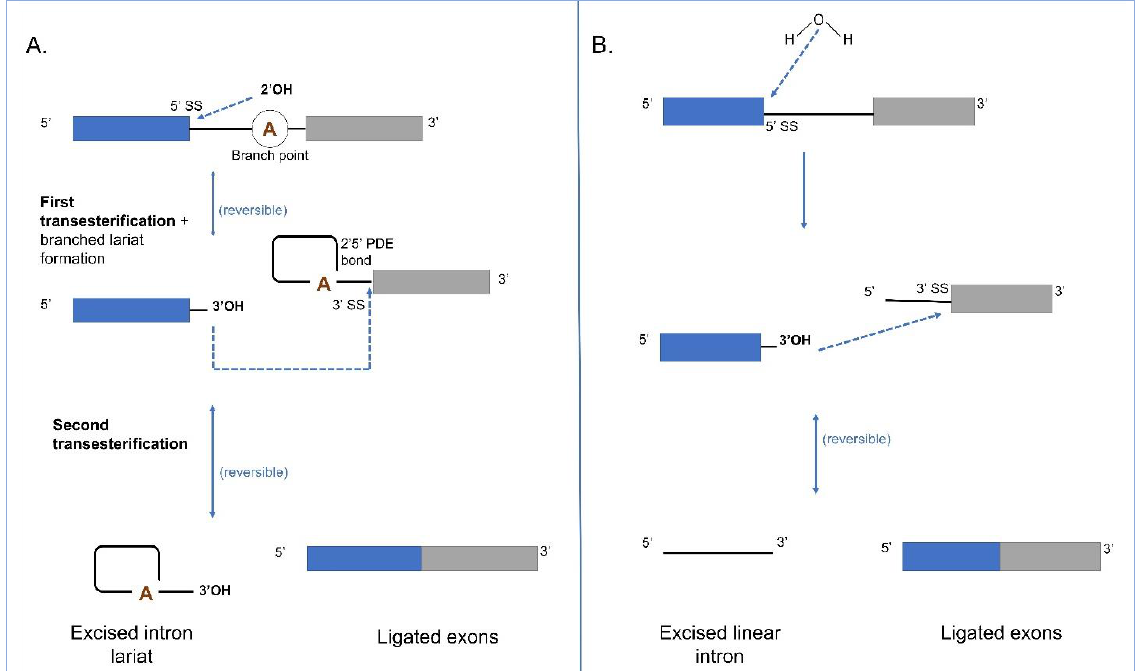
Figure 4. Schematic representation of splicing for Group II introns. ( A ) In the “branching” pathway of splicing, there are two sequential transesterification reactions. In the first reversible reaction, the 2′ OH of an internal branch point (the bulged A), located near the 3′ end of the intron attacks the 5′ splice site (SS), producing a branched lariat intermediate, stabilized by a 2′5′ linkage. In the second reversible reaction, the newly released 3′ OH of the 5′ exon attacks the 3′ SS, resulting in the ligation of the 5′ and 3′ exons and the excision of the intron lariat. ( B ) In the “hydrolytic” pathway of splicing, a water molecule or hydroxyl residue initiates the first attack on the 5 (cid:48) SS, releasing a linear RNA molecule. In the second reversible reaction, the newly released 3 (cid:48) OH of the 5 (cid:48) exon attacks the 3 (cid:48) SS similar to the branching pathway, resulting in the ligation of the 5 (cid:48) and 3 (cid:48) exons and the excision of the linear intron RNA